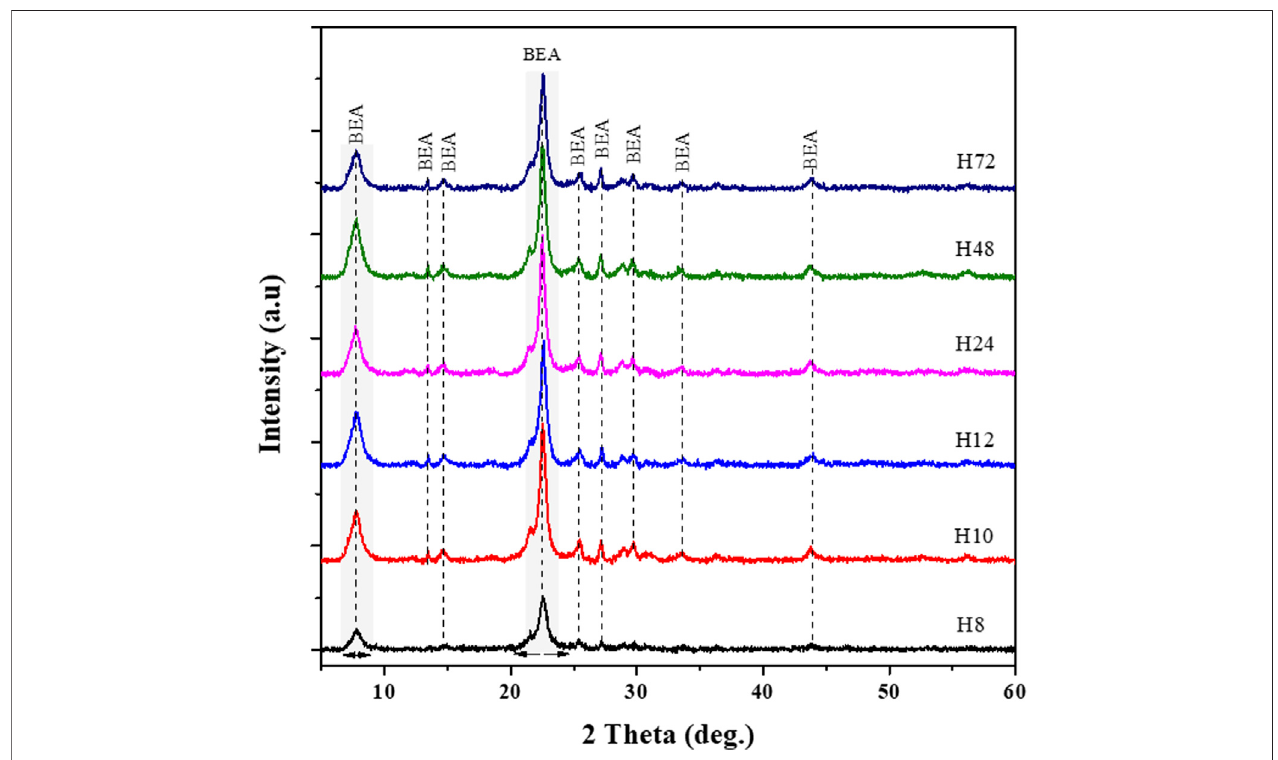
FIGURE 3 | XRD patterns of as-synthesized HBEA zeolites produced from CFA nanosilica extract at different water contents and hydrothermal times.